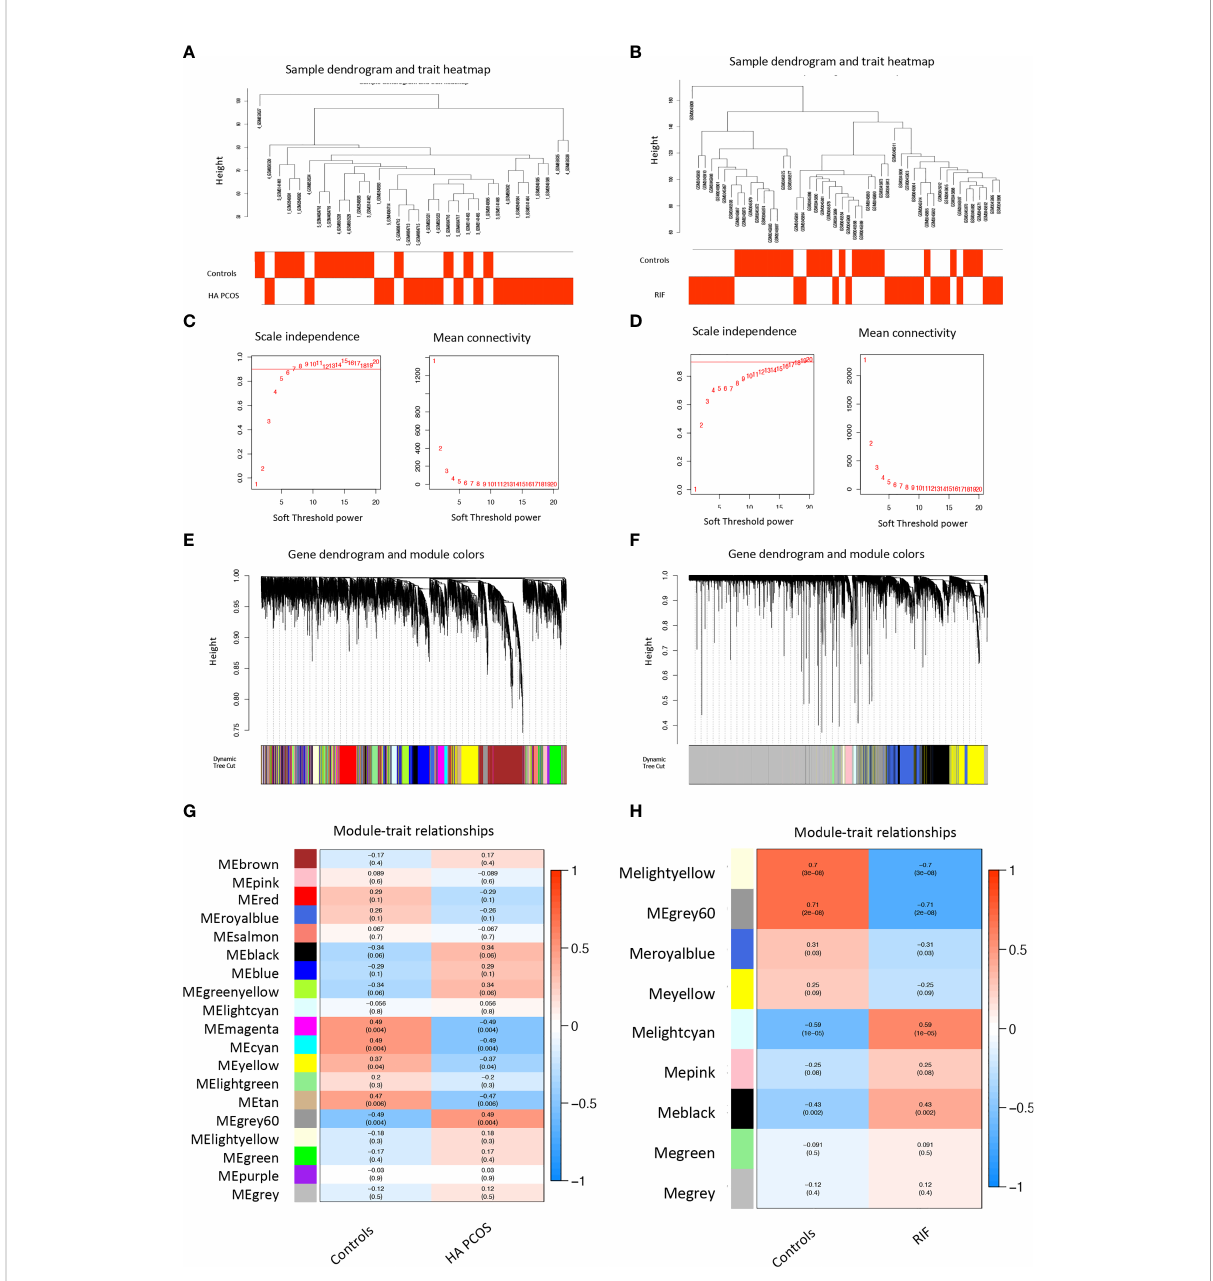
FIGURE 3 Weighted gene co-expression network analysis (WGCNA) of HA PCOS and RIF. (A) Sample clustering dendrogram of HA PCOS group and controls. (B) Sample clustering dendrogram of RIF group and controls. (C) Analysis of the scale-free index and mean connectivity for various threshold powers for HA PCOS. (D) Analysis of the scale-free index and mean connectivity for various threshold powers for RIF. (E) Clustering dendrogram of all DEGs in HA PCOS based on the measurement of dissimilarity (1-TOM). (F) Clustering dendrogram of all DEGs in RIF based on the measurement of dissimilarity (1-TOM). (G) Module – trait relationships in HA PCOS. The color band showed the corresponding correlation and p -value. (H) Module – trait relationships in RIF. The color band shows the corresponding correlation and p